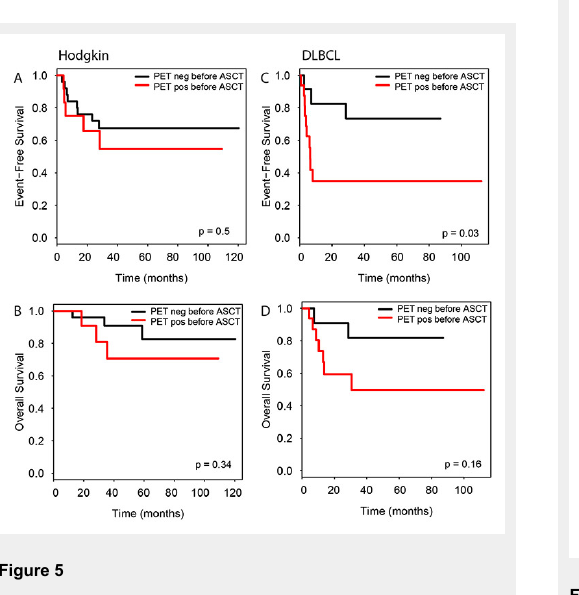
Impact of pre-transplantation PET/CT on event free and overall survival according to lymphoma entity. Hodgkin’s lymphoma (A, B) and DLBCL (C, D).